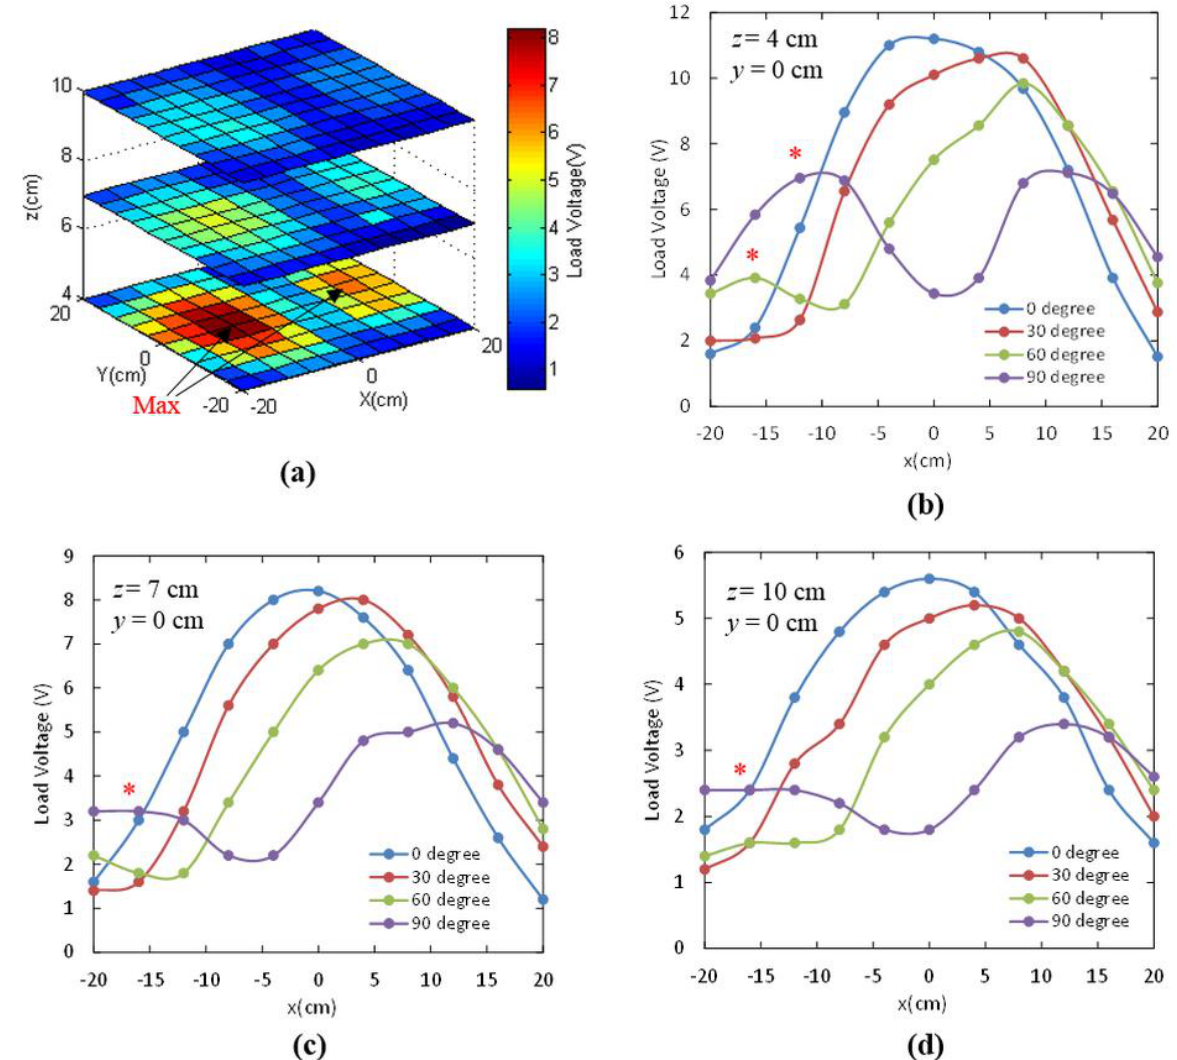
Figure 8. Measured load voltages at different distances z = 4, 7, 10 cm when a load of 745 Ω was connected to the receiver side. ( a ) The angle θ between the TX and RX antennas was 90°. Measured load voltages at the planes of y = 0 cm and ( b ) z = 4 cm; ( c ) z = 7 cm; and ( d ) z = 10 cm; with different angular misalignment θ = 0°, 30°, 60° and